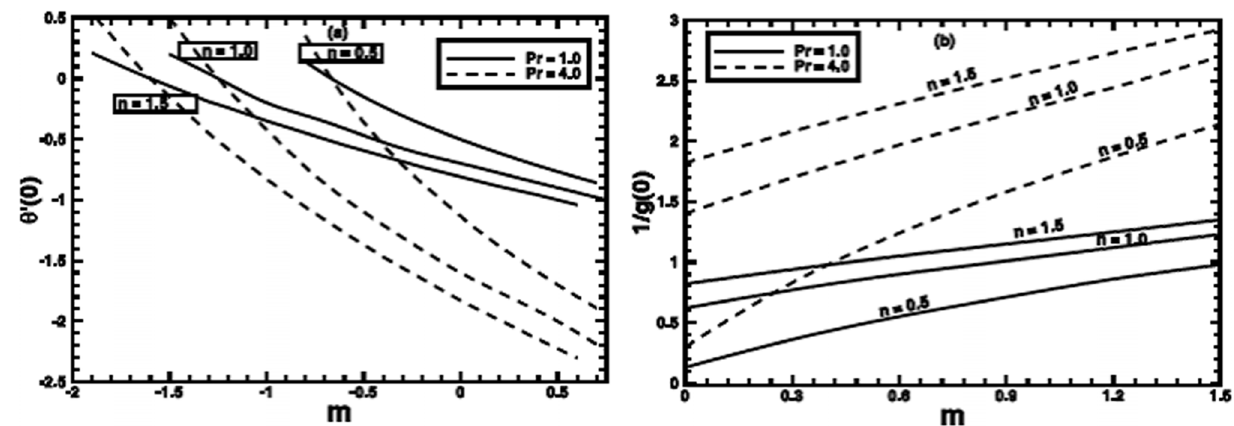
Figure 14. The variation of the local Nusselt number with m for some value of the power-law index n and Prandtl number Pr.